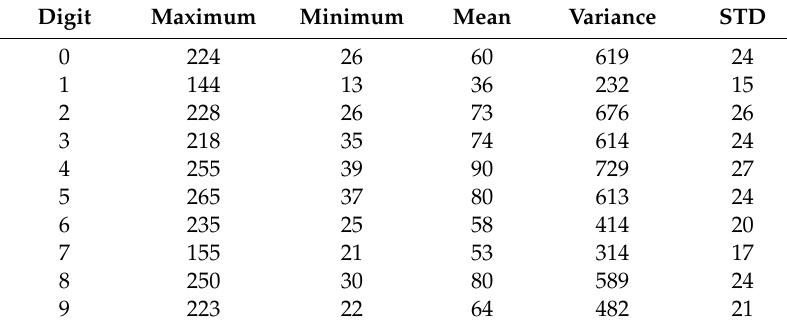
Table 1. Parameter of the RealSense trajectory digits (RTD) trajectory dataset.